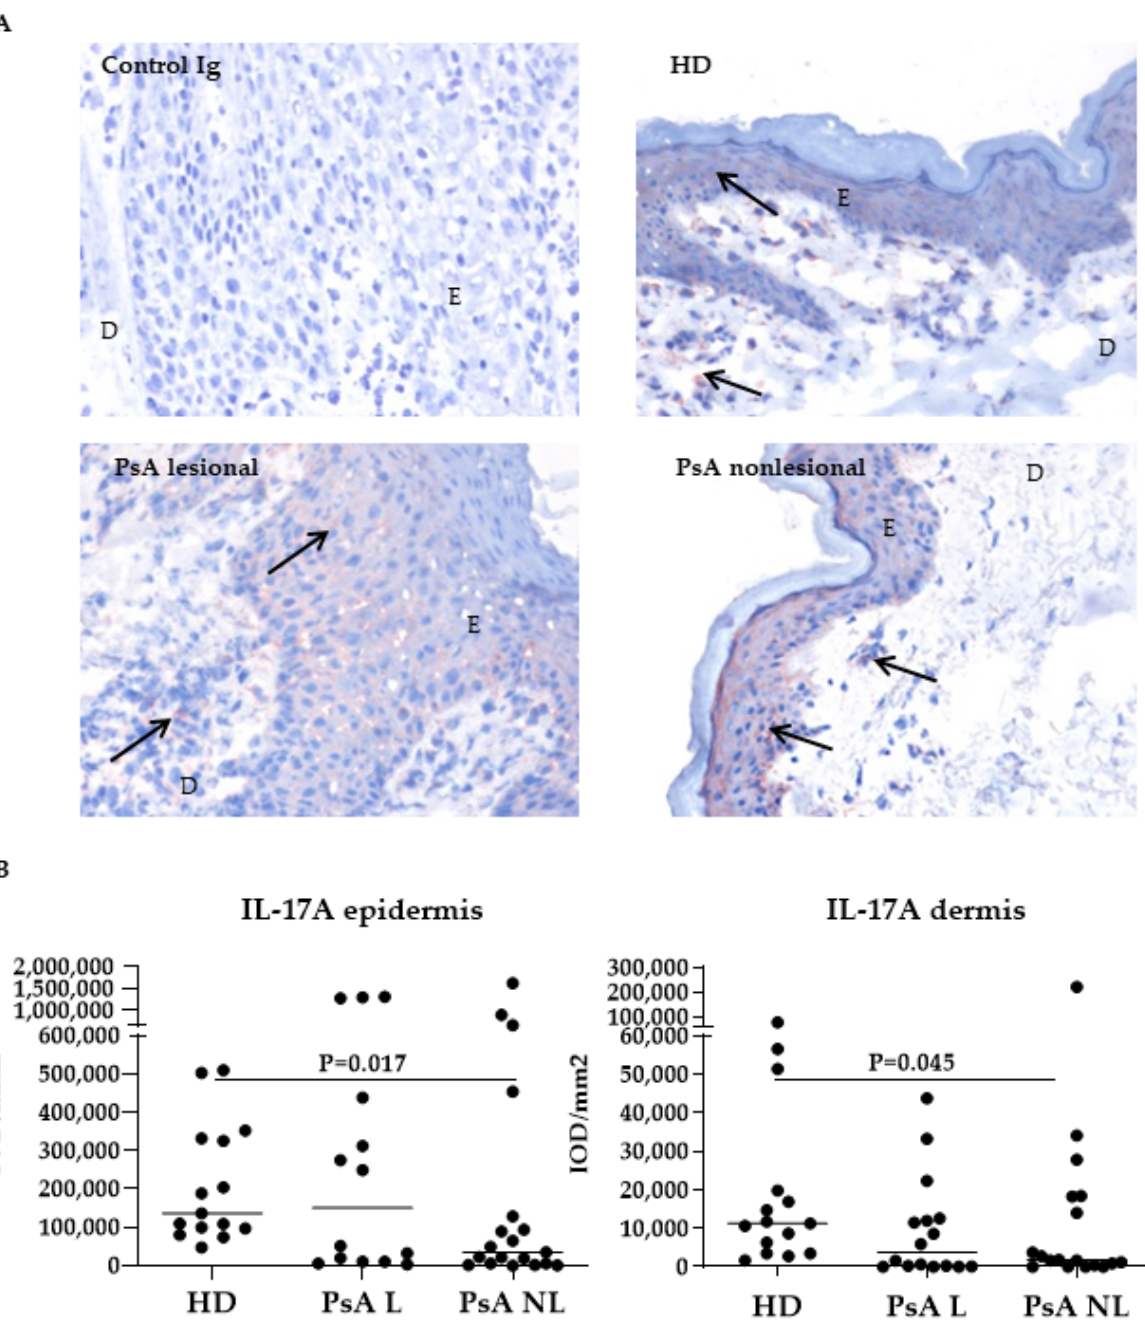
Figure 1. Expression of IL-17A was lower in the epidermis and dermis of nonlesional psoriatic skin compared to healthy donor skin. ( A ) Representative immunohistochemical staining of baseline IL-17A expression (arrows) in skin from HD and PsA patients. Original magnification 200 × . ( B ) Quantification of IL-17A (Kruskal-Wallis test, epidermis p = 0.07, dermis p = 0.07) and expression in HD, PsA L skin and PsA NL skin. Results are shown as median IOD/mm 2 and IQR of epidermis and dermis of HD and PsA patients. Per subject the median expression level of 18 high-power fields is used for analysis. E, epi-dermis; D, dermis; IL, interleukin; HD, healthy donor; PsA, psoriatic arthritis; L; lesional, NL; nonlesional, IOD; integrated optical density, IQR; interquartile